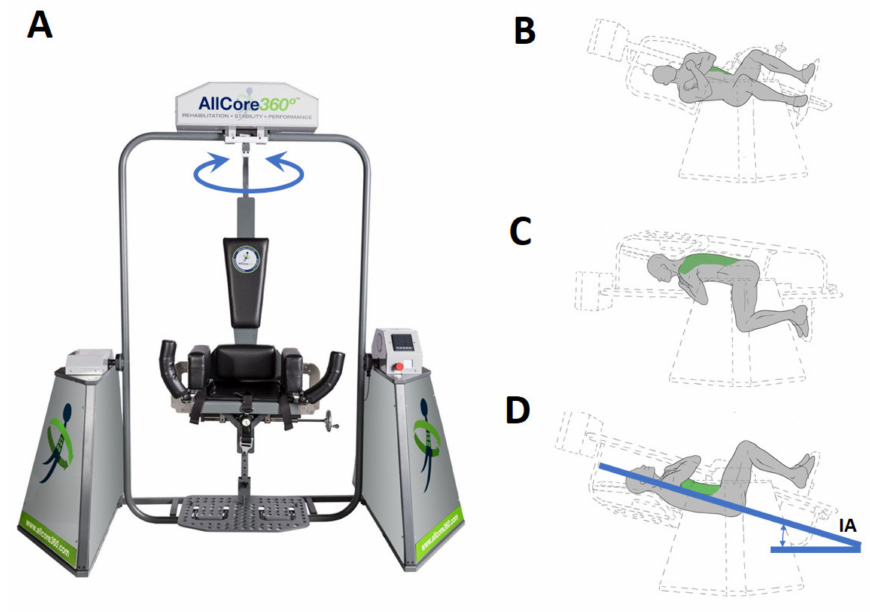
Figure 1. ( A )The AllCore360 ◦ device, and ( B – D ) different regions of the core targeted during a single rotation of the AllCore360 ◦ . IA—Inclination